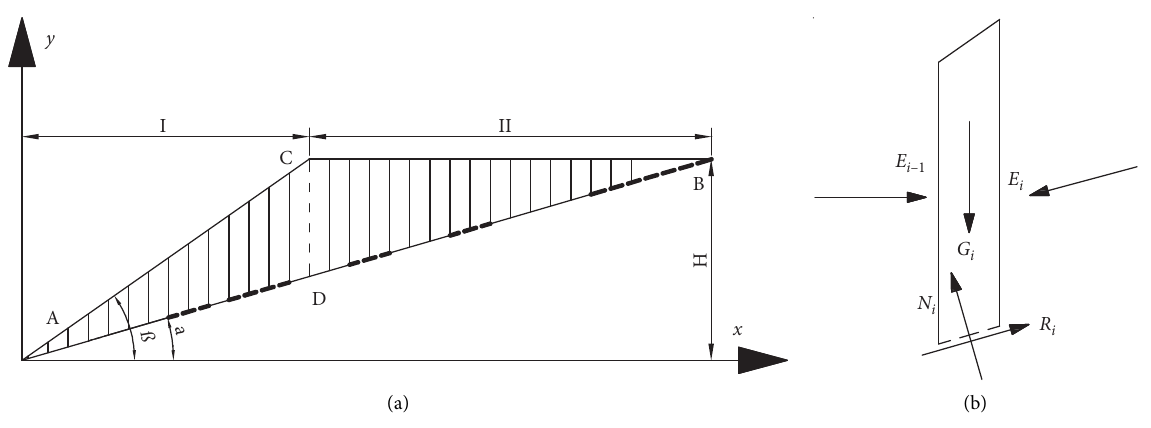
Figure 3: Dump step strip division. (a) Simplified model. (b) Stress of